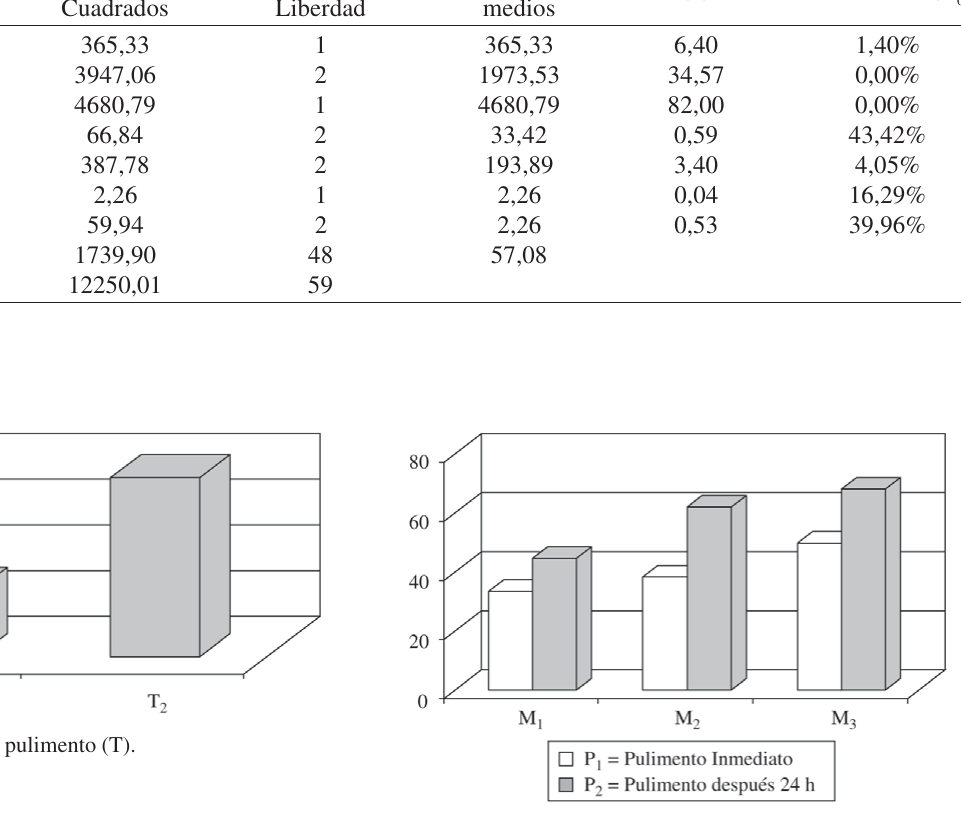
Figura 4. Interacción material (M) × momento de pulimento